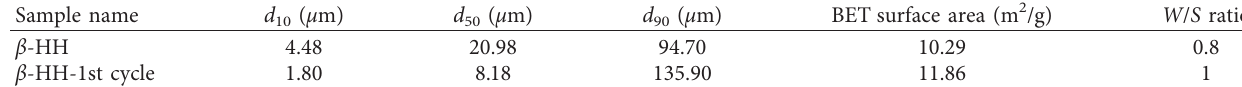
Table 2: Physical properties of pure β -HH and β -HH after the first cycle.